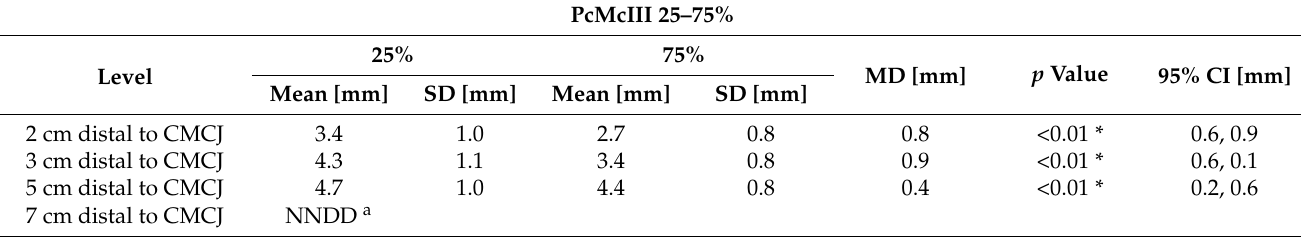
Table 3. Results of the pre-season (1st examination) and post-season (2nd examination) pooled data analysis for 12 endurance horses examined at an interval of approximately six months, using the paired samples t -test or the Wilcoxon signed-rank test for the comparison of measurements of the medial (25%) and lateral (75%) aspects of the proximal palmar cortex of the third metacarpal bone (PcMcIII) (top) and the overall thickness of the PcMcIII (the mean of the measurements obtained at 25, 50, and 75% of the PcMcIII mediolateral width) (bottom), at 2, 3, 5 and 7 cm distal to the carpometacarpal joint (CMCJ). The differences between measurements acquired at 2 cm and 3 cm, 3 cm and 5 cm and 5 cm and 7 cm, respectively, are each compared. NNDD—not normally distributed data, Proximal—the more proximal of the two levels compared (measured in cm from the CMCJ); distal—the more distal of the two levels compared (measured in cm from the CMCJ); SD—standard deviation; MD—mean difference; CI—confidence intervals. * = statistically significant; p < 0.05.